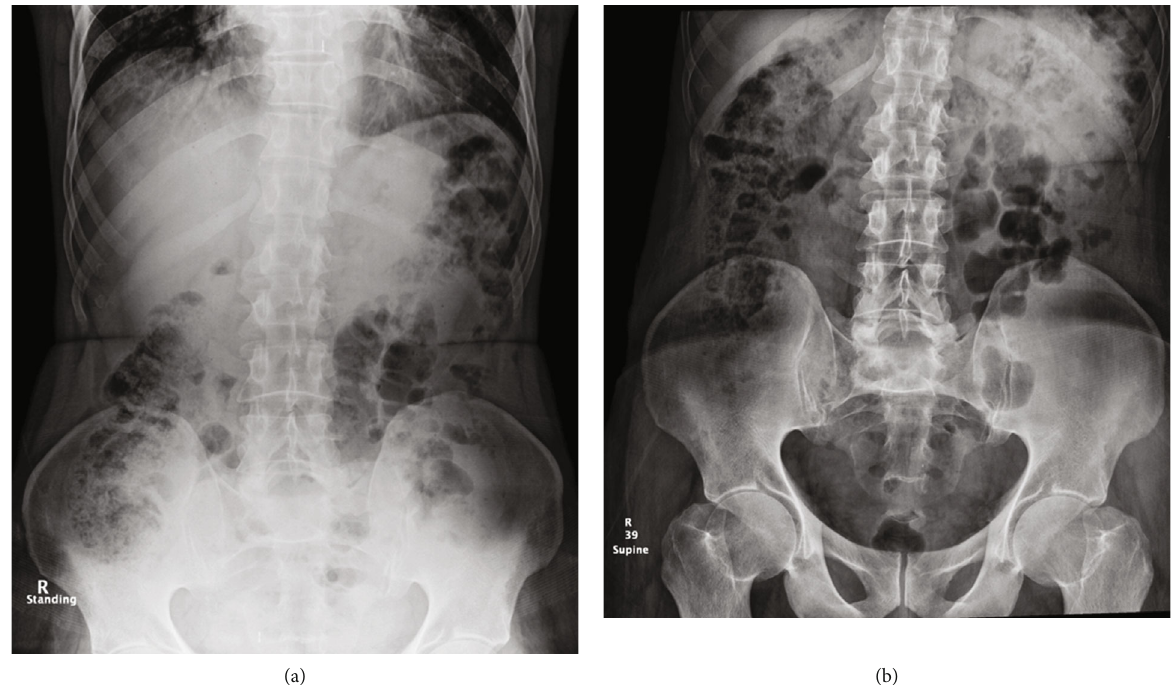
Figure 1: Erect (a) and supine (b) abdominal X-ray radiographs showing colonic fecal and gas